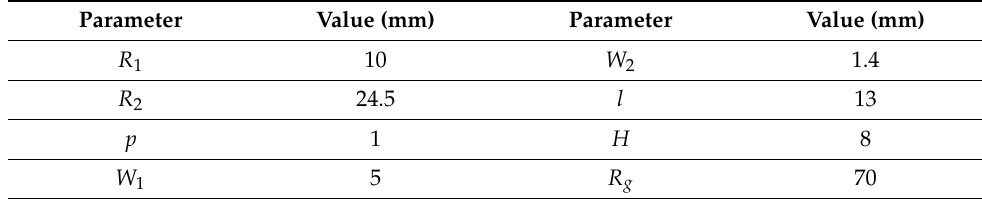
Table 2. Parameters of reconfigurable antenna.